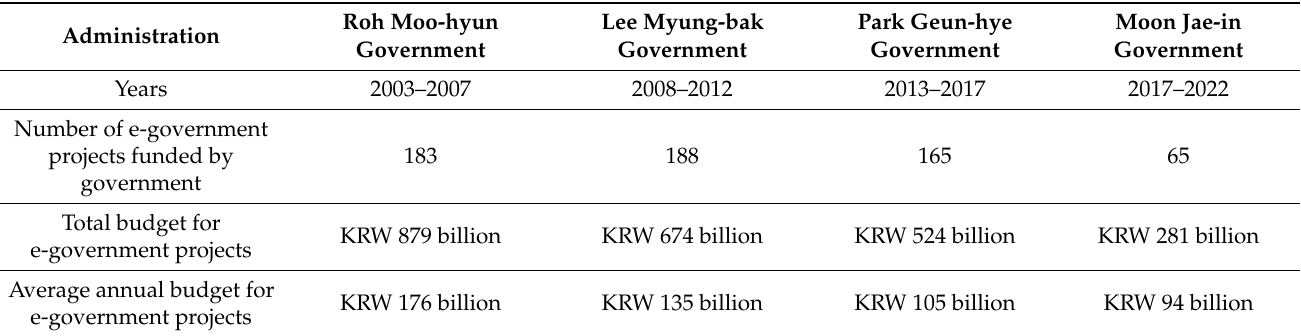
Table 6. The Government Budget for E-government Projects